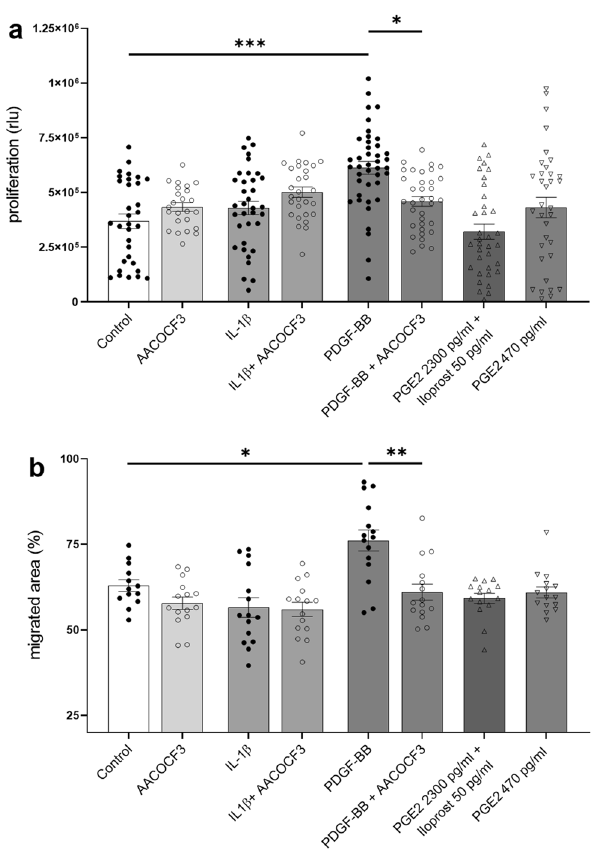
Figure 5. Inhibition of cPLA2 with AACOCF3 1 μM reduces proliferation, secretion, and prostaglandin secretion. AACOCF3 reduced PDGF-BB driven cell proliferation ( a ) and migration ( b ). No effect was observed when PGE2 and iloprost (PGI2) were administered together (mimicking their secretion levels obtained after 24 h IL-1β stimulation of mesangial cells) and at low PGE2 concentrations (mimicking PGE2 secretion levels